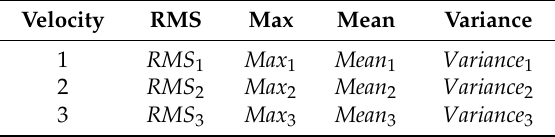
Table 2. Feature extraction for velocity condition.